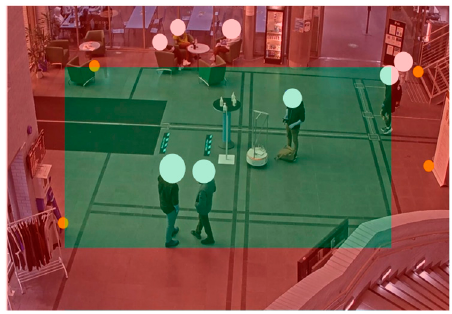
Figure 6. Division of the FoV of a CCTV camera into regions.